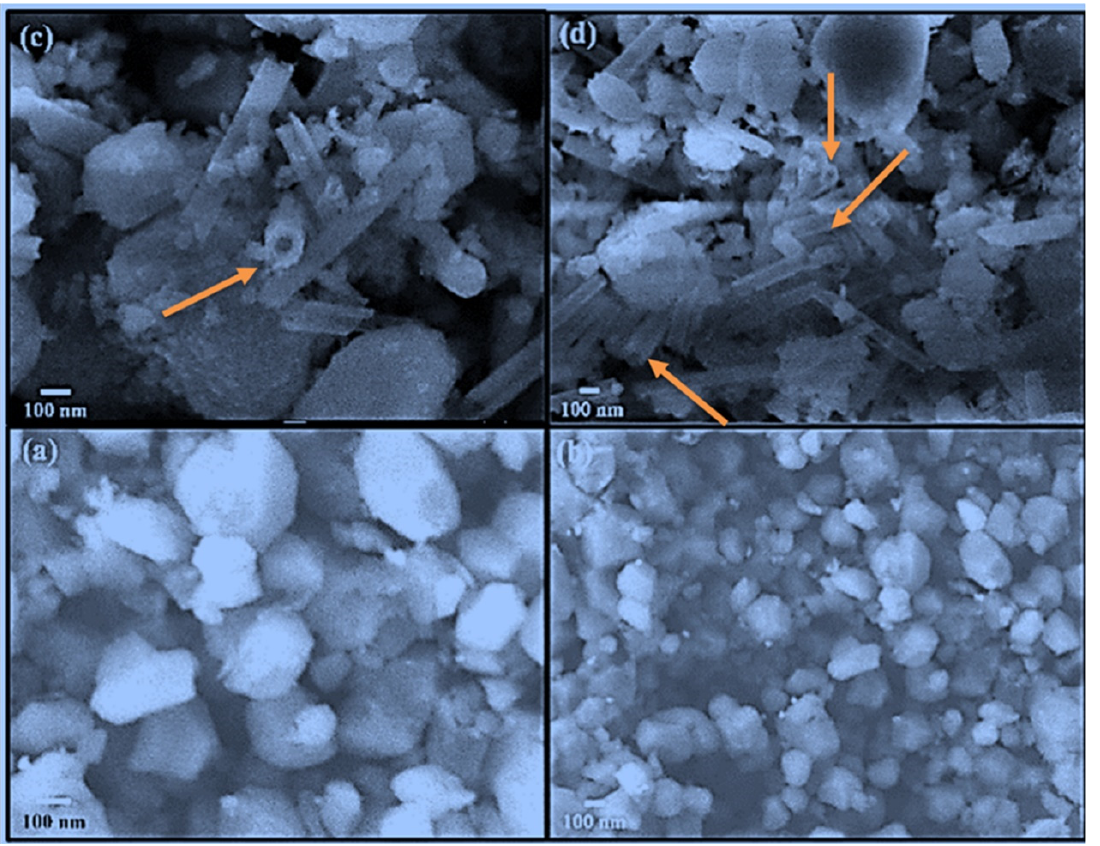
Figure 2. The SEM images of ( a , b ) pure HAP and ( c , d ) CS-HAP-CeO 2 heterostructure. The arrows represent the CeO 2 nanotubes embedded in HAP nanomatrix.